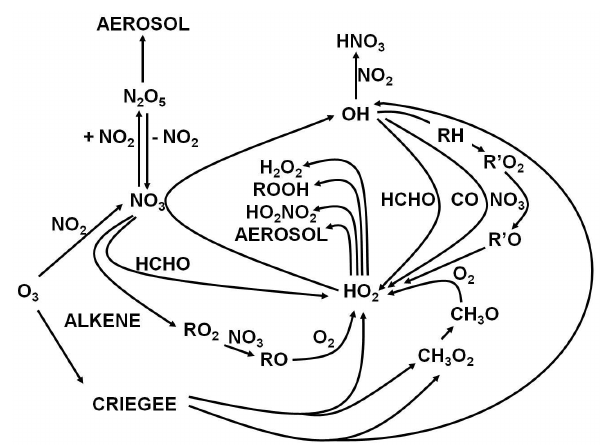
Figure 11: Schematic summarising the dominant chemical pathways occurring during tropospheric Fig. 11. Schematic summarising the dominant chemical pathways oxidation at night during RONOCO. occurring during tropospheric oxidation at night during